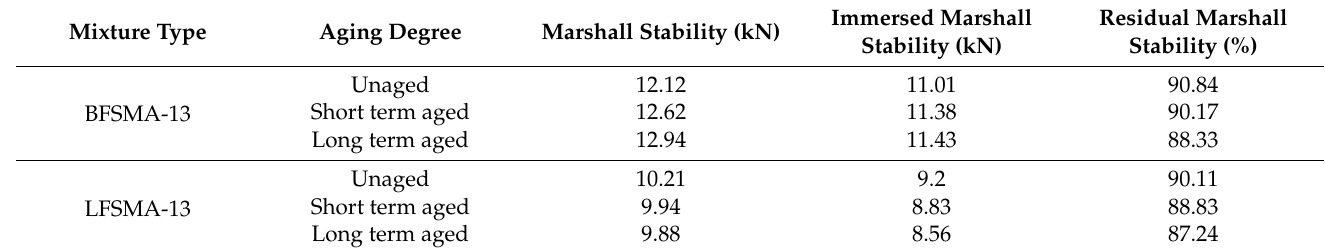
Table 7. Water stability